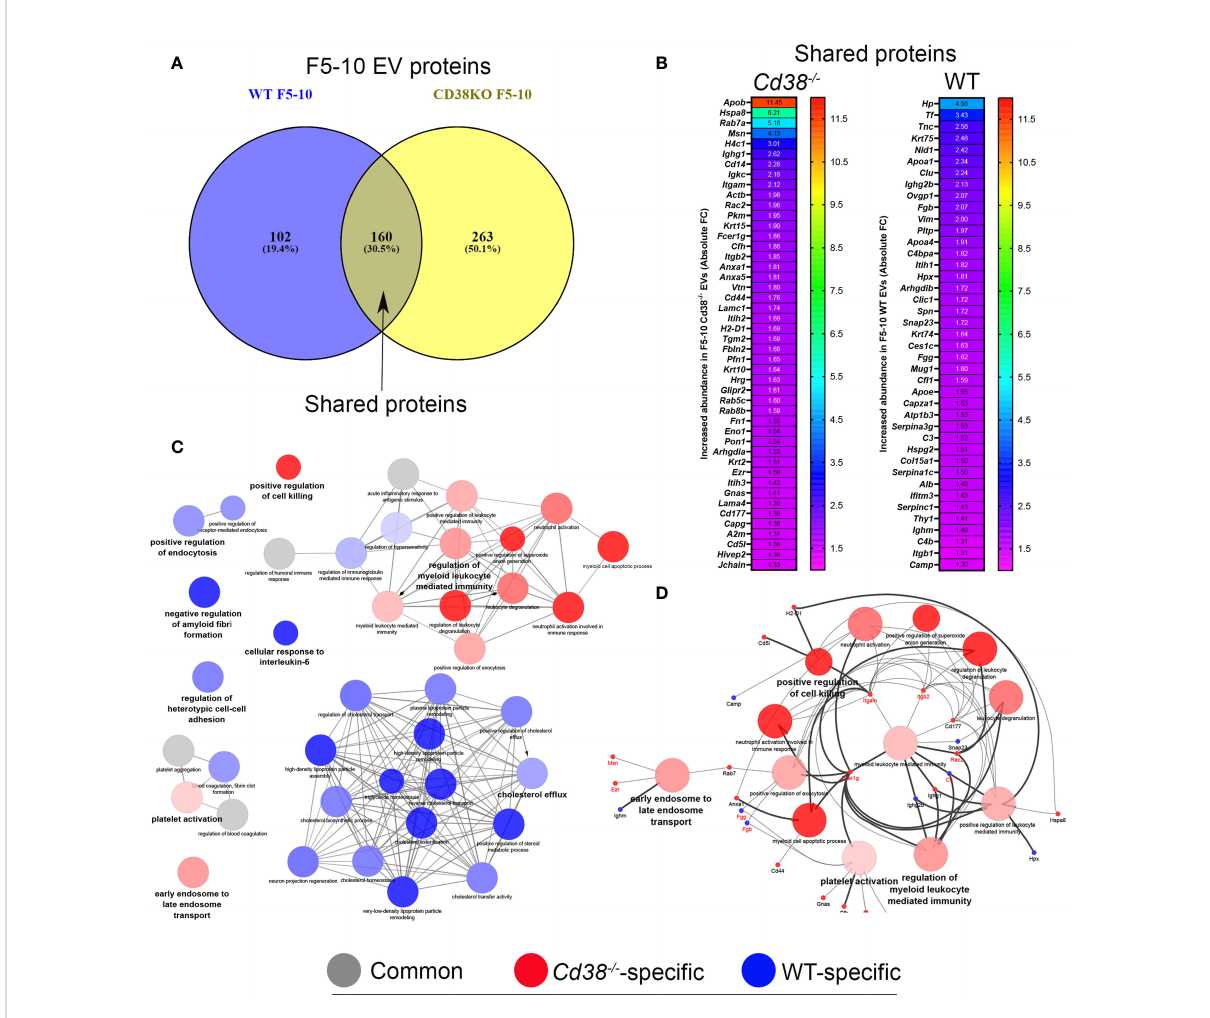
FIGURE 5 (A) Venn diagram highlighting the number of shared proteins identi fi ed in both peritoneal F5-10 Cd38 -/- EV and F5-10 WT EV from pristane- treated mice. (B) Heat-maps showing the increased protein abundance in F5-10 Cd38 -/- EV relative to F5-10 WT EV (left), or the increased protein abundance in F5-10 WT EV relative to F5-10 Cd38 -/- EV (right). The absolute Fold-Change (FC) (X-axis) in (B) was calculated as described in Material and Methods. Only proteins with a cutoff ≥ 1.3 are shown. For clarity the gene names of the proteins are shown. (C) Network of terms generated with the proteins common to F5-10 Cd38 -/- EV and F5-10 WT EV, which showed an absolute FC ≥ 1.3. The network has been created using the ClueGO and Cluepedia applications of Cytoscape, with the GO Biological Process; pV < 0.05. From the 2 proteins clusters that were compared, 3 categories of terms were generated: terms speci fi c for F5-10 Cd38 -/- EV (red), terms speci fi c for F5-10 WT EV (blue), and common terms (grey). The node size is indicative of the term statistical signi fi cance. Terms are considered speci fi c for a given cluster when >60% of the proteins are originating from one of the clusters. The term with the highest statistical signi fi cance within each functional group is highlighted in bold and de fi nes the name of the functional group. (D) Network highlighting the genes associated with the 13 functional terms speci fi c for F5-10 Cd38 -/-